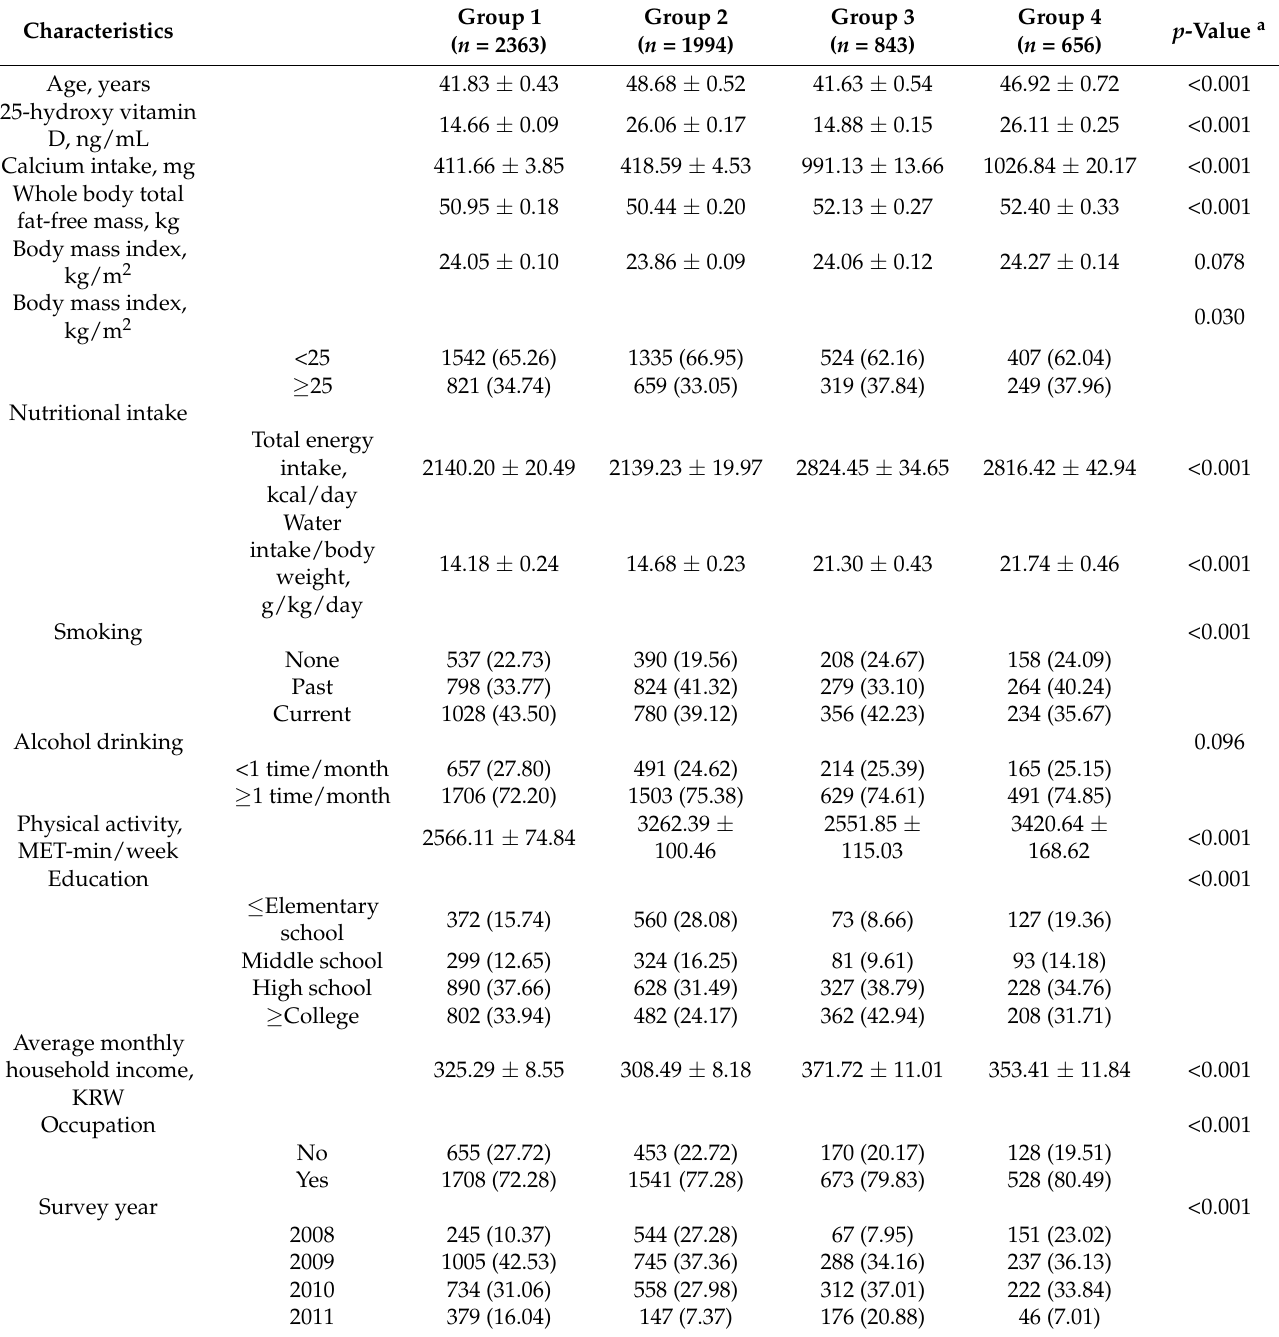
Table 2. Comparison of basic characteristics by group in